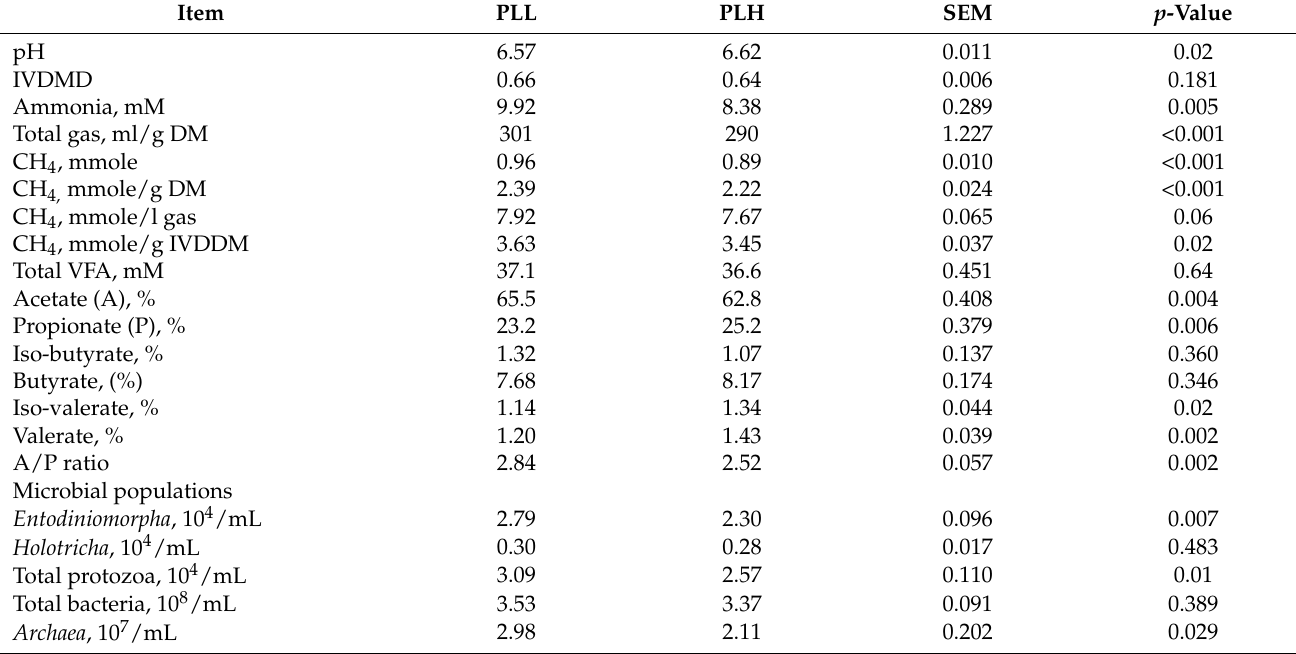
Table 3. The effect of Paulownia leaves with lower concentration of bioactive components (PLL) and Paulownia leaves with high concentration of bioactive components (PLH) on in vitro ruminal fermentation, methane production, and microbial populations (experiment 1).